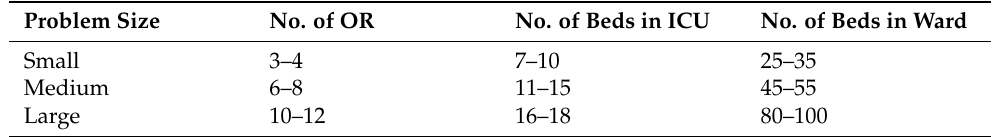
Table 1. Characteristics of the different-sized